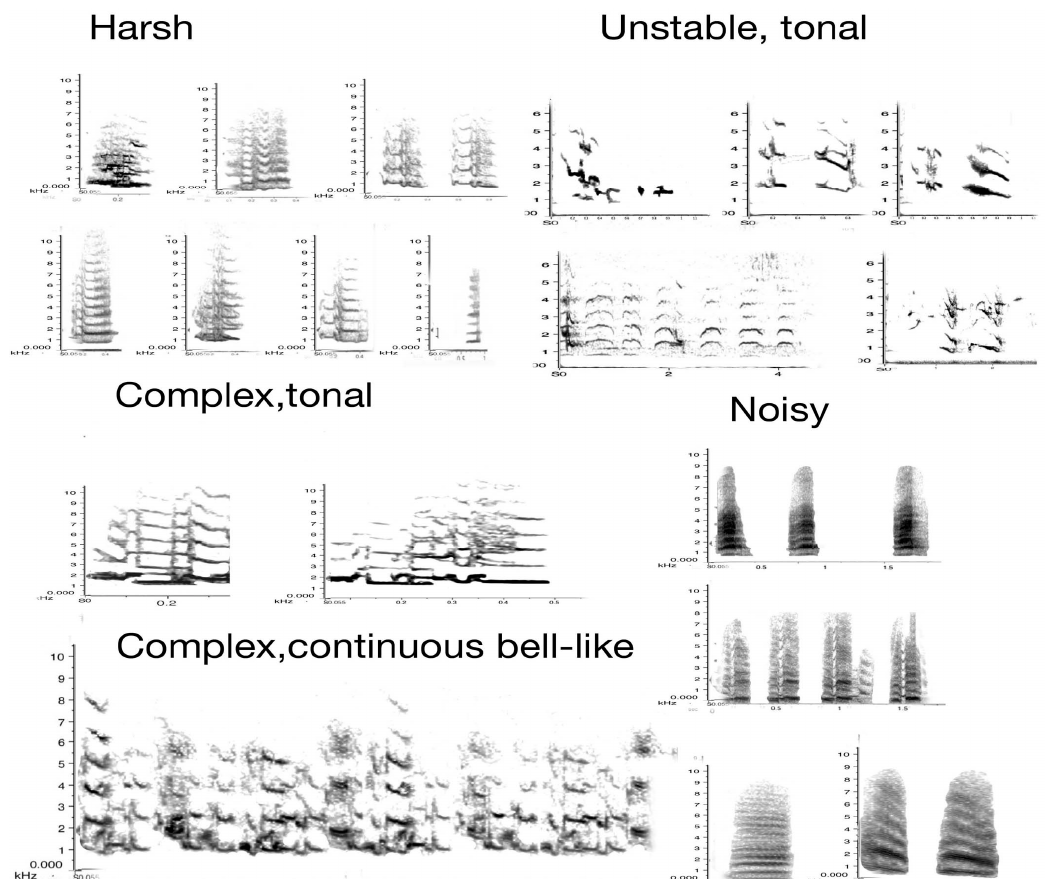
Figure 8. Acoustic profile of adult magpie vocalisations. Y-axis: frequency standardised to 10 kHz, except for the group of unstable sounds (standardized at 6 kHz). X-axis: time in seconds. Individual calls or sounds of 0.2–0.5 s. The exception in this figure is the “complex/continuous” sound that was recorded over 32 s.